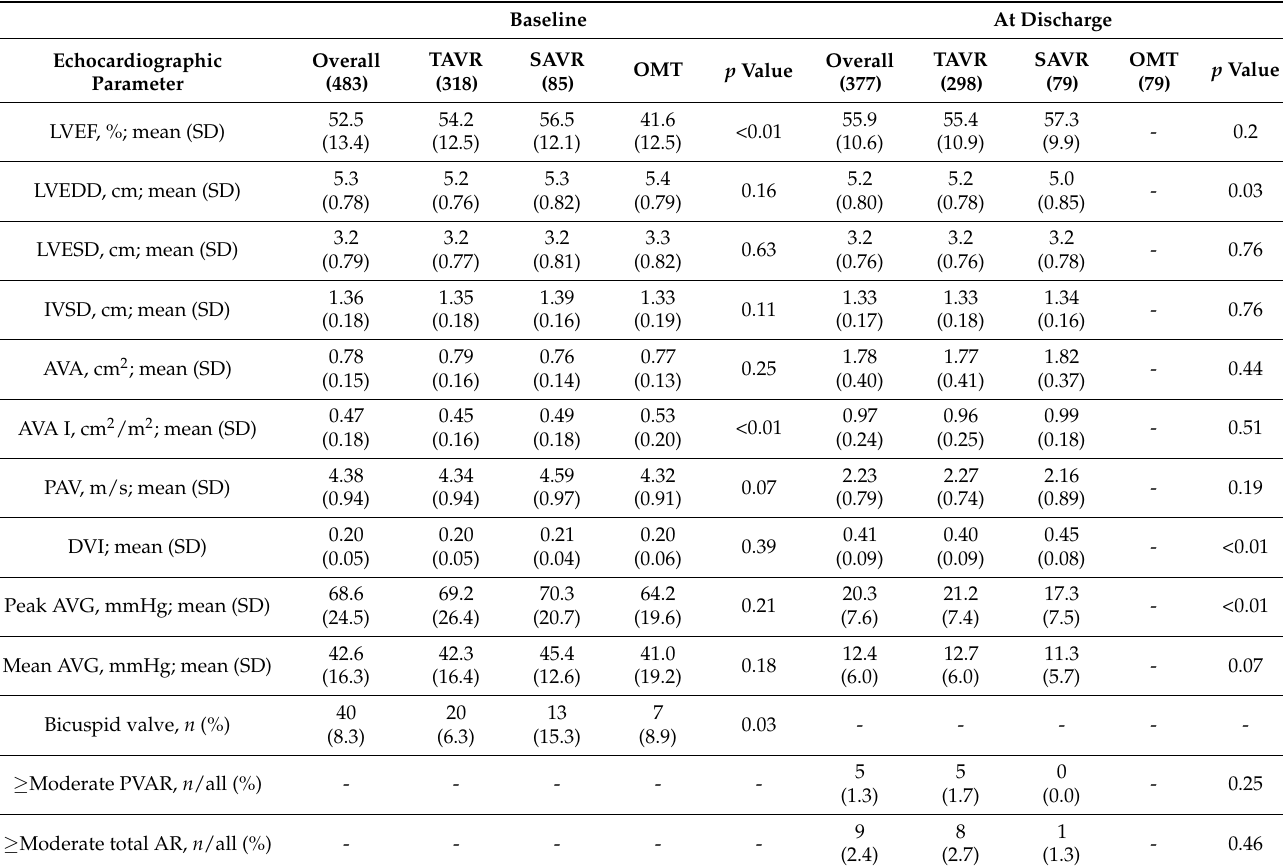
Table 2. Echocardiographic parameters before and after Heart Team (HT) decisions